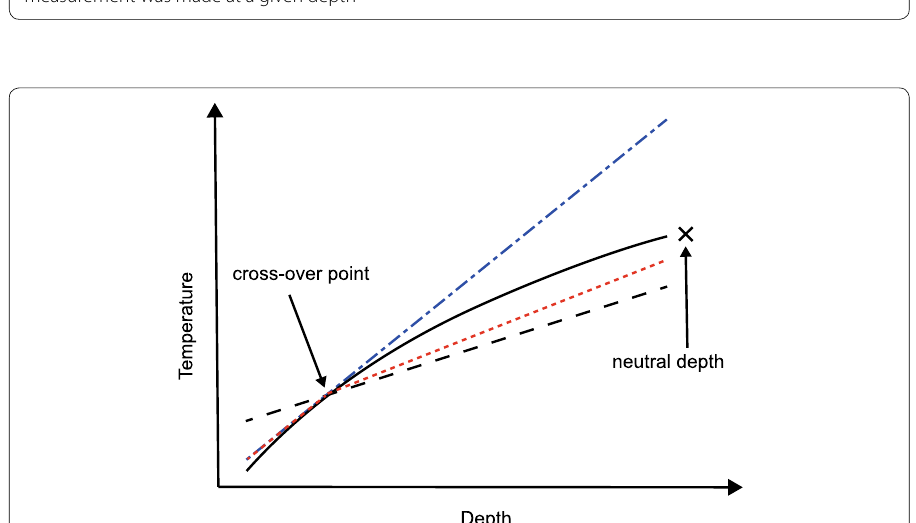
Fig. 4 Sketch of the effects of the different correction methods on the temperature data. Black dashed line: original temperature log; blue dash-dotted line: method A; black solid line: method B; red dotted line: method